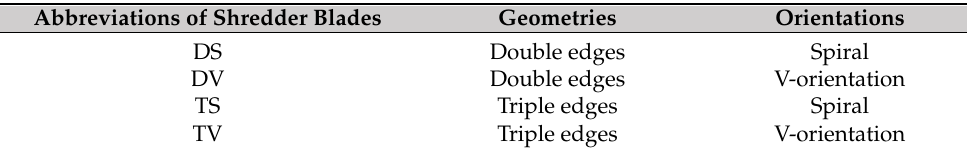
Table 1. Abbreviations of shredder blades in different geometries and orientations.